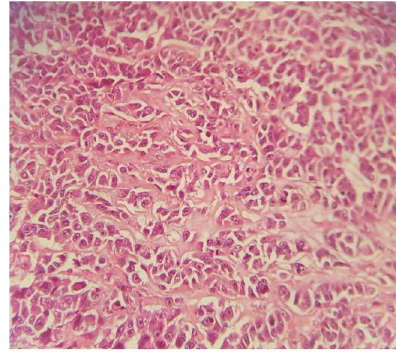
Figure 5. Endometrial carcinoma, H and E